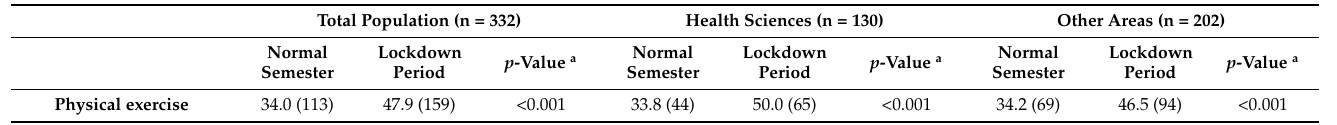
Table 5. Physical exercise practice between the normal semester and the lockdown period due to the COVID-19 pandemic, according to the area of study.